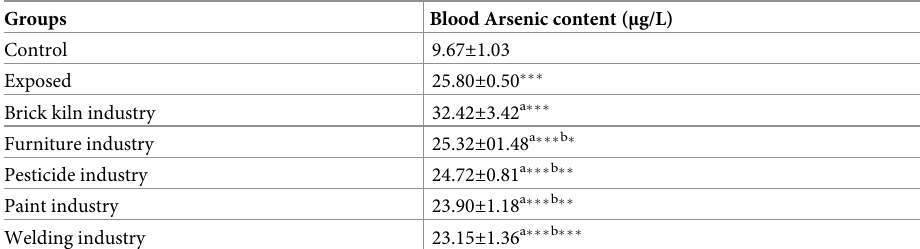
Table 3. Arsenic content in blood samples of controls and workers of different